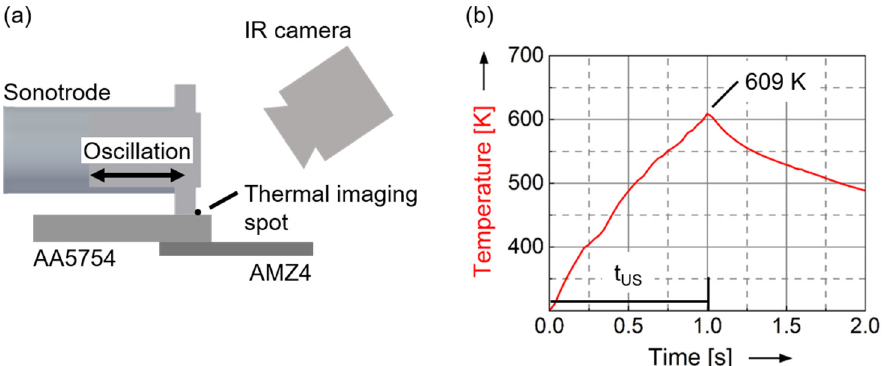
Figure 7. ( a ) Schematic illustration of the temperature measurement setup for infrared imaging. The thermal imaging spot is located at the center of the weld spot between the tip and the aluminum sheet. ( b ) Evaluation of the thermal imaging spot. The maximum temperature is measured 609 K after a processing time of 1 s.